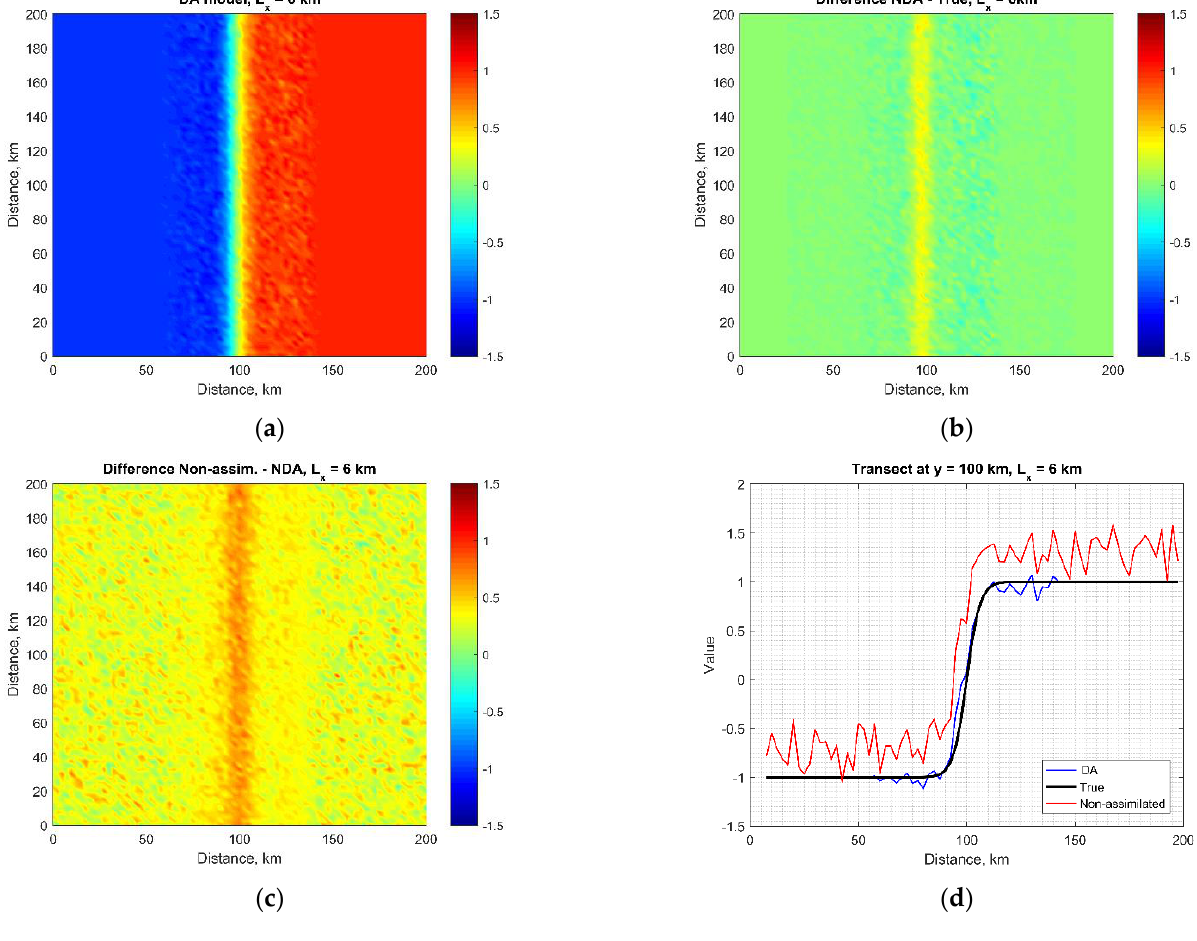
Figure 3. Assimilation results for the ocean front shown in Figure 2: ( a ) child model after NDA assimilation, ( b ) difference between the assimilated model and the true field, ( c ) difference between the non-assimilated and assimilated child models, ( d ) zonal transects of the previous fields along a line at 𝑦 = 100 km.